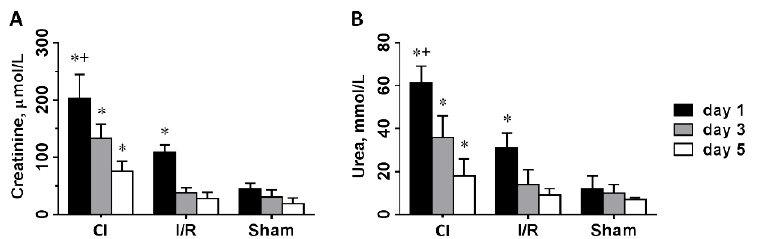
Figure 1. Glomerular and tubular functional parameters, creatinine ( A ) and urea ( B ) retention 1, 3 and 5 days after left kidney operation. CI: cold ischemia, I/R: ischemia-reperfusion, Sham: sham operated (n = 8 in all groups). *: p < 0.05 vs. sham, +: p < 0.05 vs. I/R (day 1).